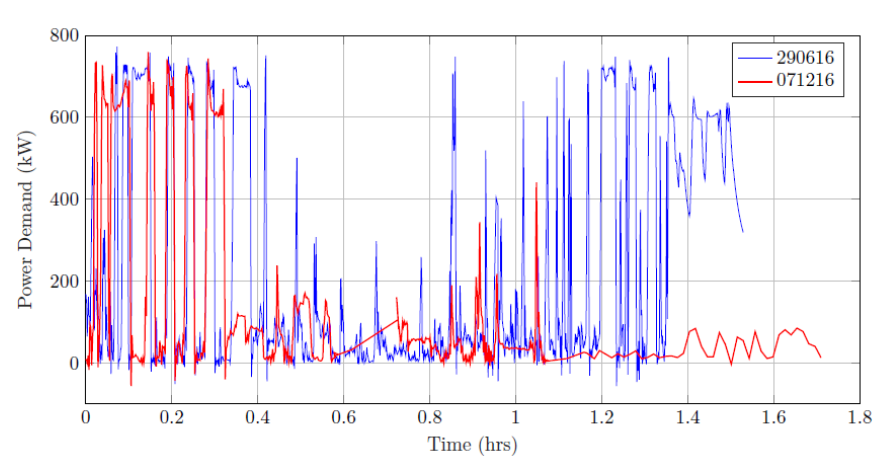
Figure 15. Plot of demand for 29.06.16 and 07.12.16